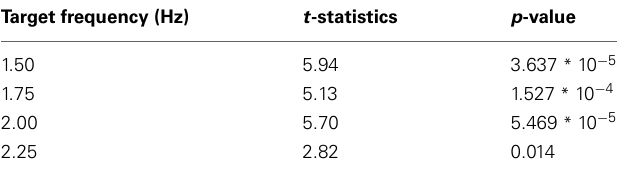
Table A2 | Statistical two-sided paired t -test comparisons of FFT pupil power between target and distracter frequencies ( n = 15).